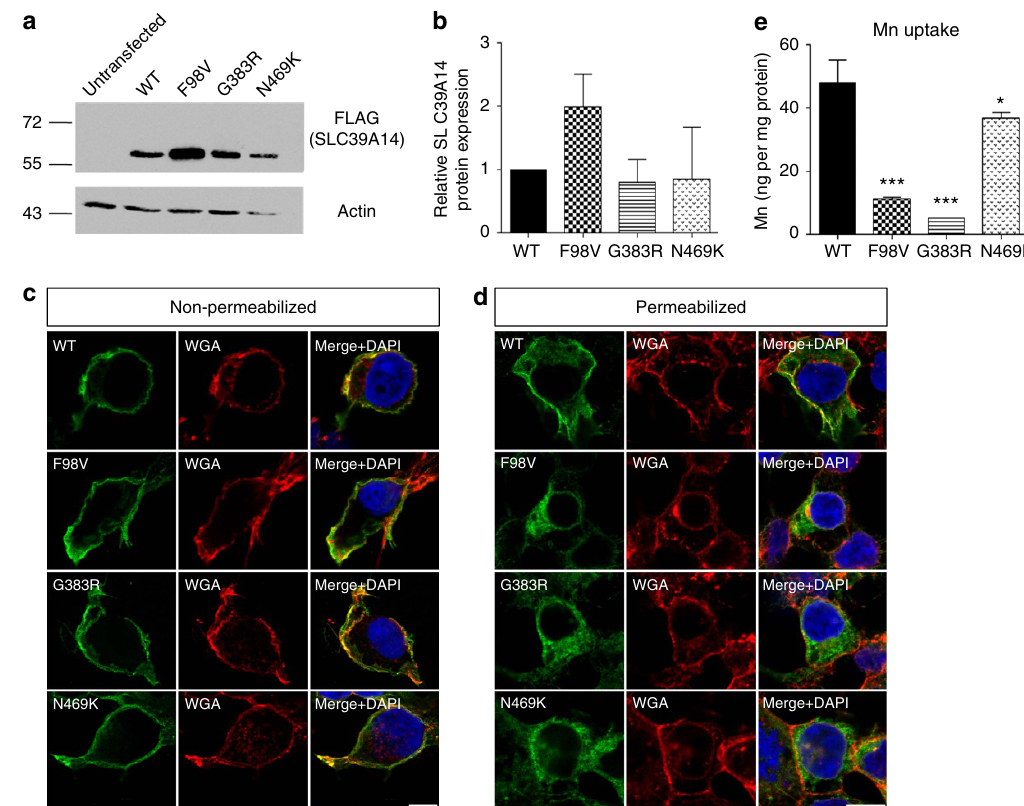
Figure 4 | In vitro expressed mutant SLC39A14 shows compromised Mn uptake despite normal subcellular localization. ( a ) Immunoblot of whole-cell lysates of stably transfected HEK-293 cells showing expression of the wild-type and three mutant SLC39A14 proteins. Actin was used as a loading control. ( b ) Quantification of SLC39A14 protein levels relative to actin expression revealed no significant difference between wild-type and mutant SLC39A14. Data are presented as means ± s.d. from three repeat experiments. Statistical analysis was performed using one-way ANOVA ( P ¼ 0.071). ( c , d ) Confocal images of stably transfected HEK-293 cells expressing FLAG-tagged SLC39A14 (green) showing that wild-type and mutant transporters co-localize with wheat germ agglutinin (WGA)-labelled plasma membrane (red) in ( c ) non-permeabilized HEK-293 cells and show additional intracellular localization in ( d ) permeabilized HEK-293 cells. Nuclei are stained with DAPI. Scale bars, 10 m m. ( e ) Mn influx studies in HEK-293 cells stably expressing wild-type (WT) and mutant forms of SLC39A14 show a decrease in Mn uptake for all SLC39A14 mutants ( P ¼ 0.000 [F98V], P ¼ 0.000 [G383R], P ¼ 0.02 [N469K]. Data are presented as means ± s.d. from three technical replicates. Statistical analysis was performed using one-way ANOVA ( P ¼ 0.000) and Tukey’s multiple comparison test (* P o 0.05, *** P o 0.001). ANOVA, analysis of variance.